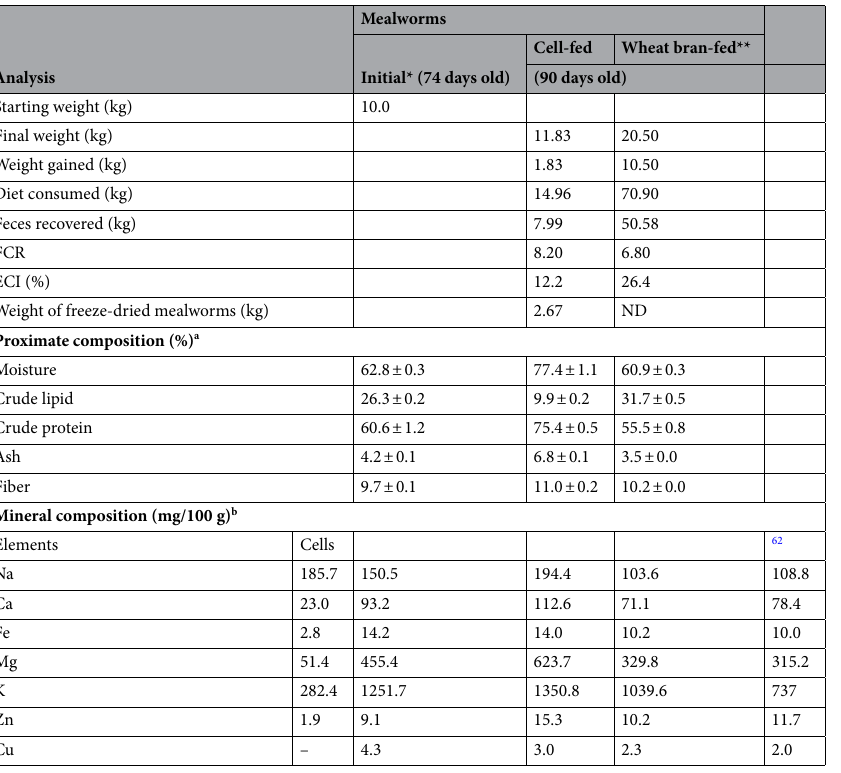
Table 2. Growth performance, feed utilization efficiency, proximate composition (% DM), and mineral composition (mg/100 g on a dry weight basis) of cells, cell-fed and commercial mealworms . FCR feed analysis. *Mealworms raised on wheat bran. ** Fed by the mealworm farmers. Values are given as mean ± SD. Superscripts denote significant